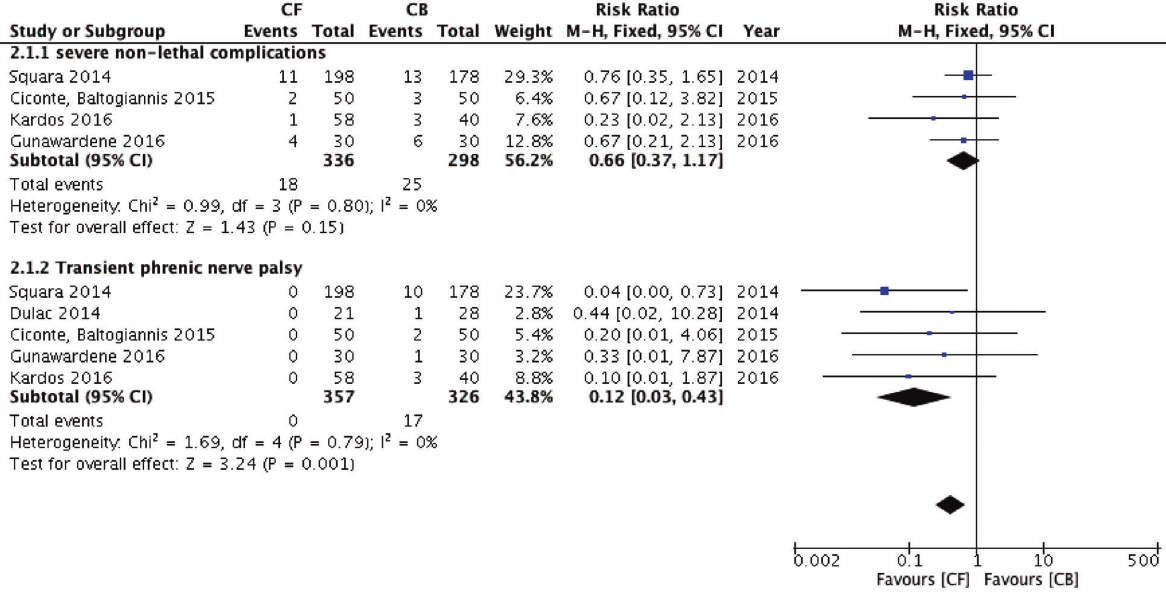
Figure 4. Forest plot showing the risk ratio and 95%CI in the incidence rate of complications among studies comparing contact force (CF) and cryoballoon (CB)